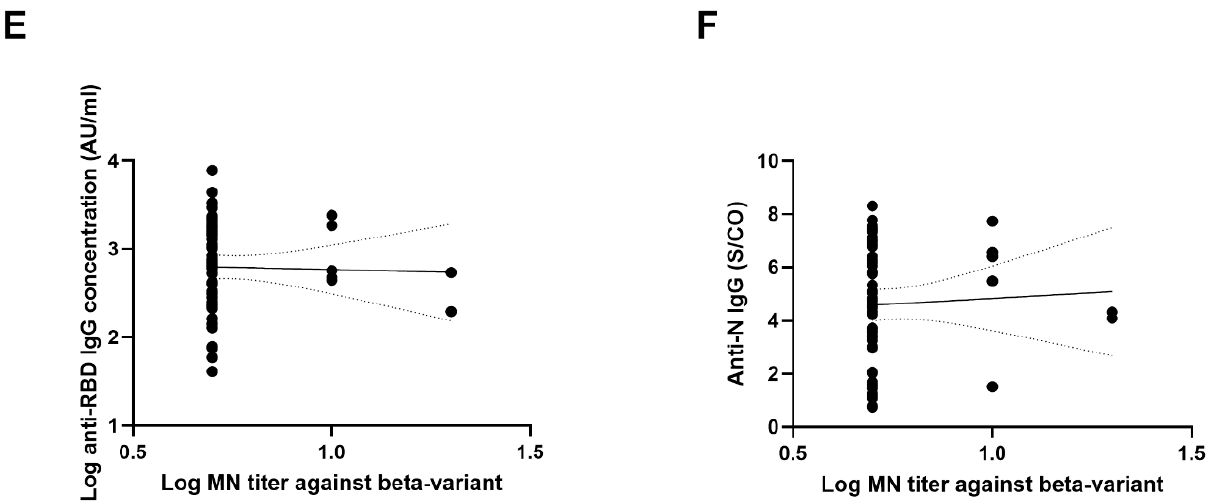
Figure 1. Correlation between MN titer and anti-N or anti-RBD IgG titers. ( A ) Comparison between MN titers against wild type lineage A virus (HKU-001a) and lineage B.1.351 virus (beta variant). The data represent geometric mean titer and 95% confidence interval ****, p < 0.0001. ( B ) Correlation between anti-RBD IgG and anti-N IgG. ( C , D ) Correlation between MN titer against wild type lineage A and anti-RBD IgG ( C ) or anti-N IgG ( D ); ( E , F ) Correlation between MN titer against lineage B.1.351 and anti-RBD IgG ( E ) or anti-N IgG ( F ). For ( B – F ), the solid lines indicate the best fit line, while the dotted lines indicate the 95% confidence interval.